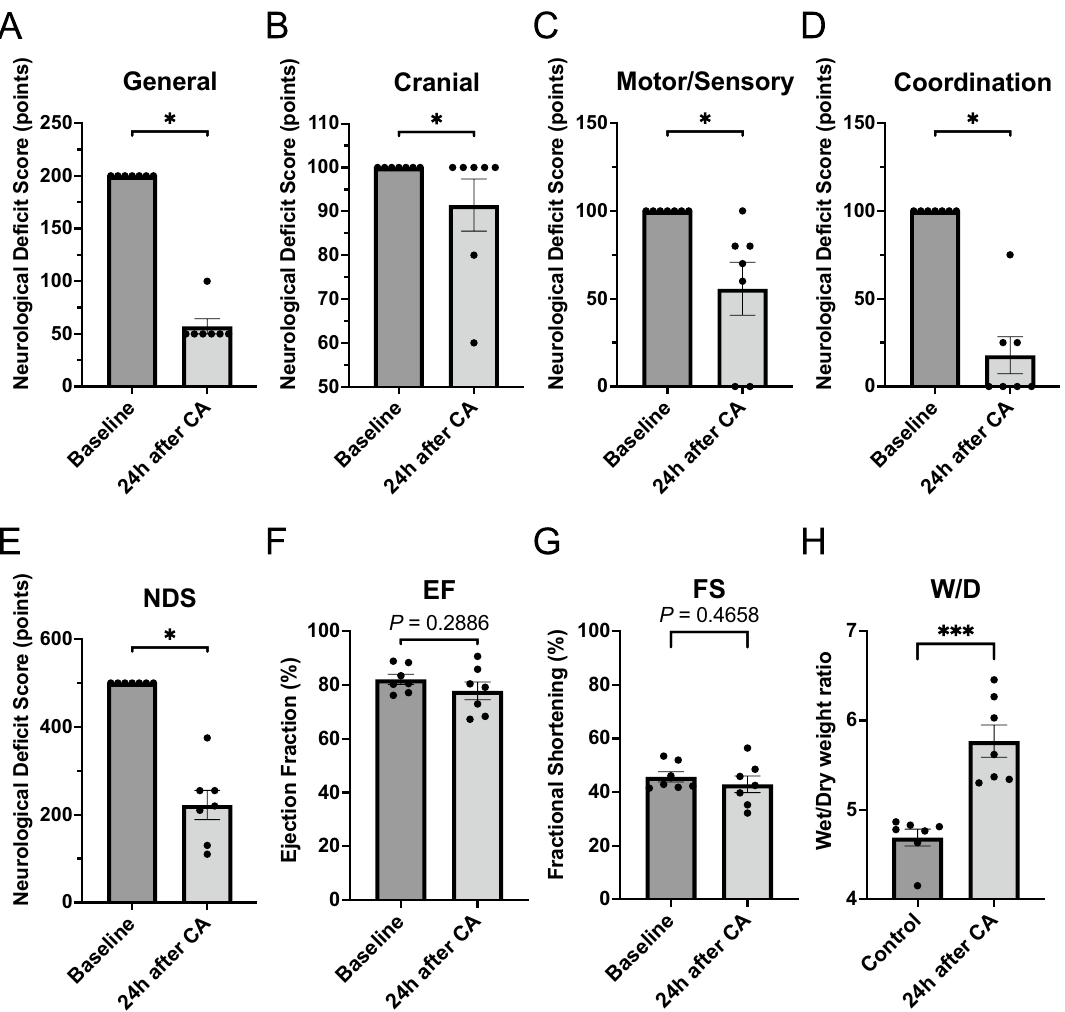
Figure 3. Physiological insults and functional deficits of tissues after CA. ( A ) Modified Neurological Deficit Score (mNDS), scores of general appearance. Baseline vs. 24 h after CA, N = 7. ( B ) mNDS, scores of cranial nerves. Baseline vs. 24 h after CA, N = 7. ( C ) mNDS, scores of motor/sensory nerves. Baseline vs. 24 h after CA, N = 7. ( D ) mNDS, scores of coordination. Baseline vs. 24 h after CA, N = 7. ( E ) mNDS, total scores. Baseline vs. 24 h after CA, N = 7. ( F ) Ejection fractioning (EF). Baseline vs. 24 h after CA, N = 7. ( G ) Fractional shortening (FS, %). Baseline vs. 24 h after CA, N = 7. ( H ) Wet/dry (W/D) weight ratio of lung tissue. Control vs. 24 h after CA. N = 7, respectively. Data were shown as mean ± SEM with scatter dot plot. * P < 0.05, *** P < 0.001, A–G; Wilcoxon matched-pairs signed rank test, H; Mann–Whitney